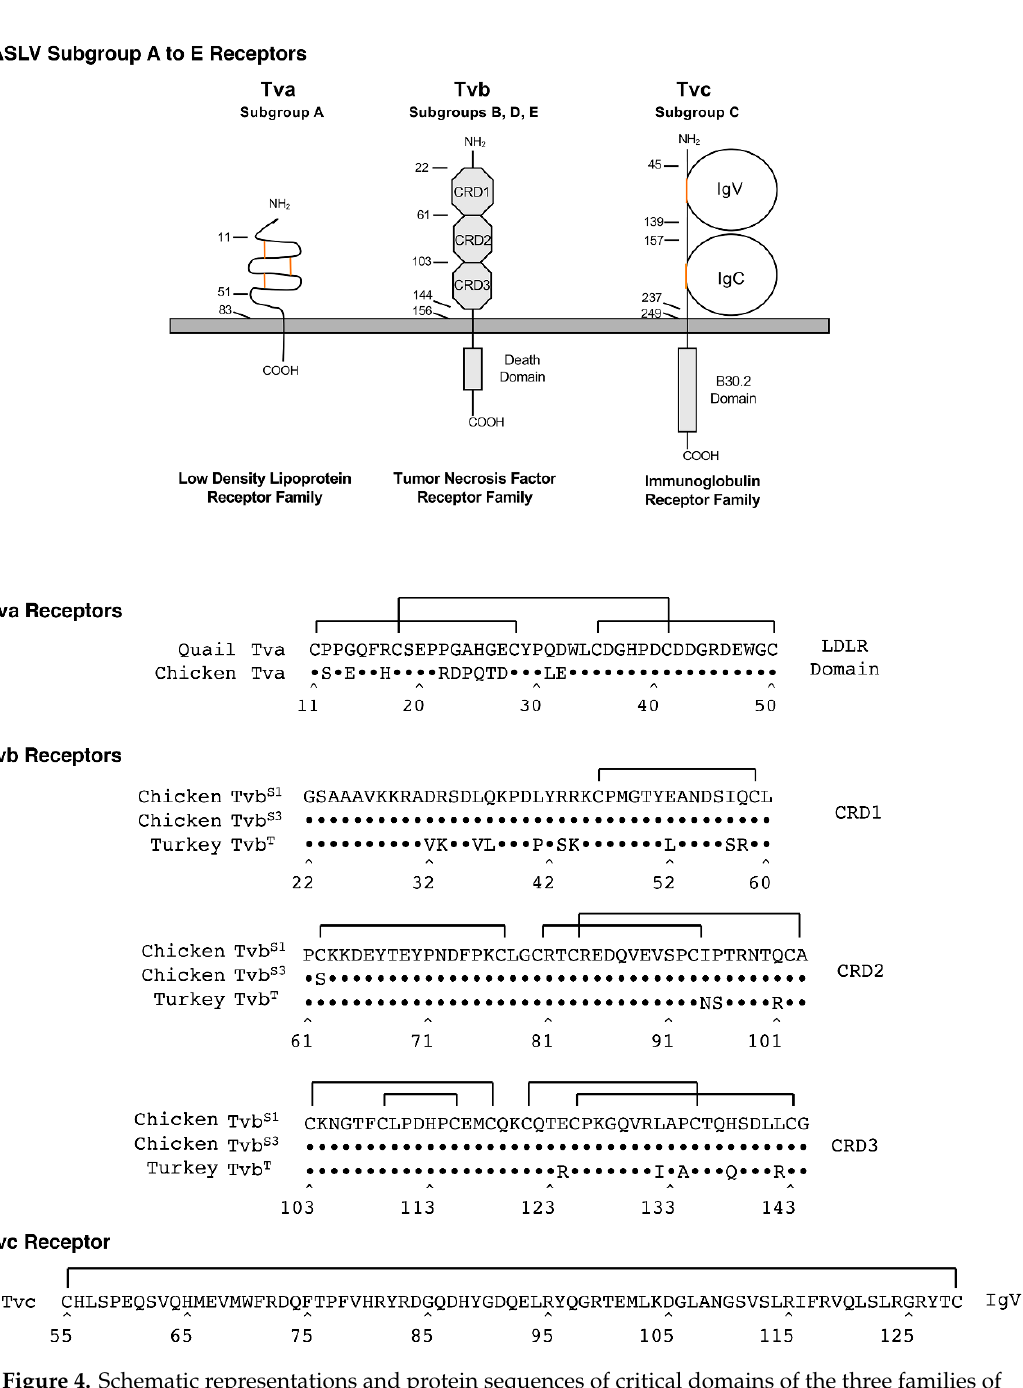
Figure 4. Schematic representations and protein sequences of critical domains of the three families of cellular surface proteins used as subgroup A to E ASLV receptors.